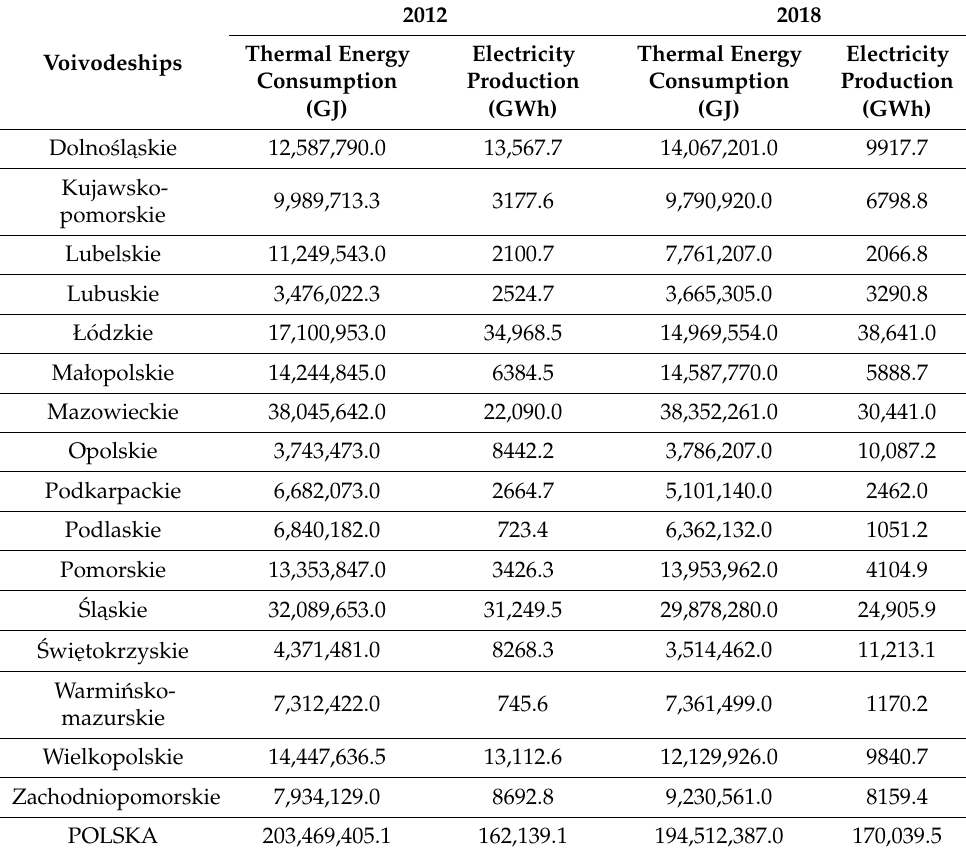
Table A1. Consumption of heat energy and production of